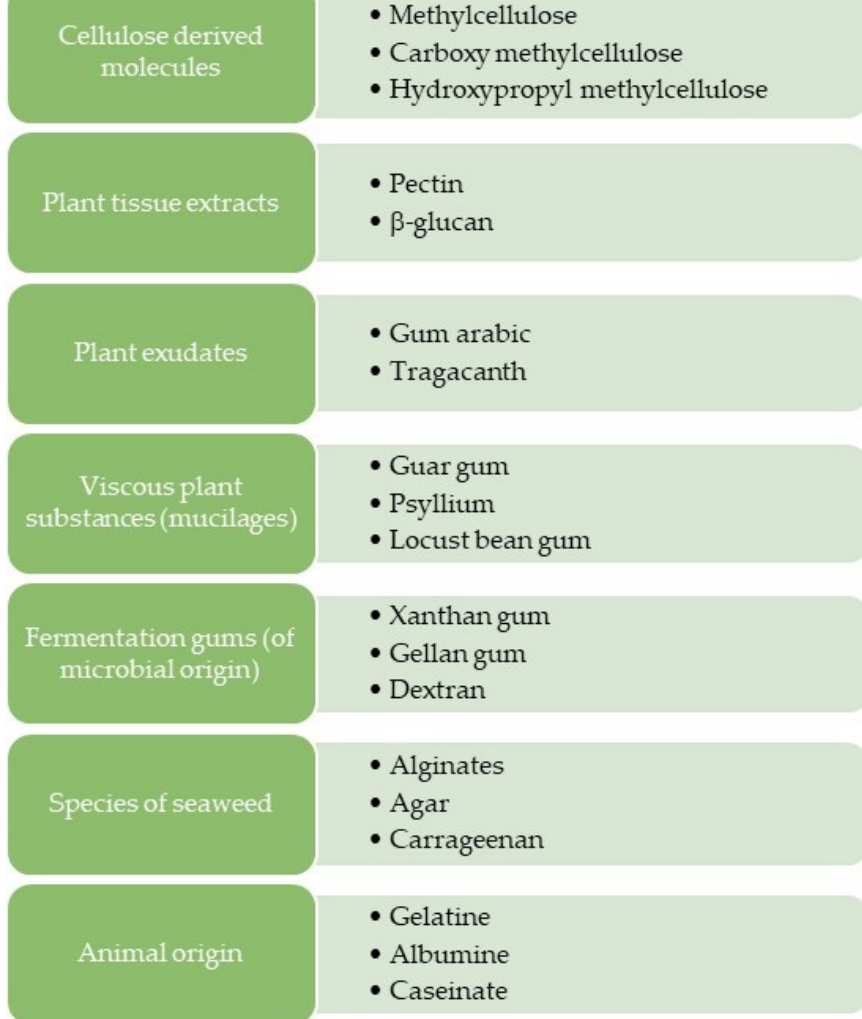
Figure 1. Classification of the main hydrocolloids according to their origin.